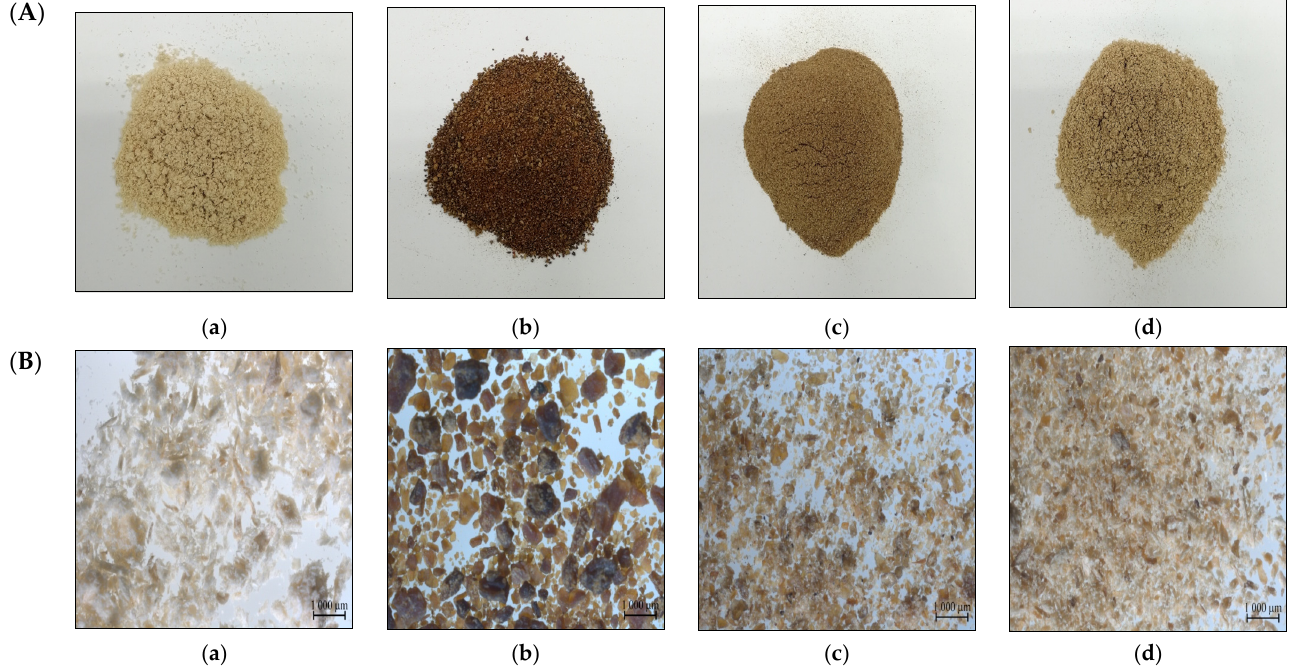
Figure 1. ( A ) Photographs of mushroom powders obtained by different drying methods; ( B ) the light microscope of mushroom powders (×25): ( a ) FD; ( b ) HAD; ( с ) MWD; ( d ) SD.